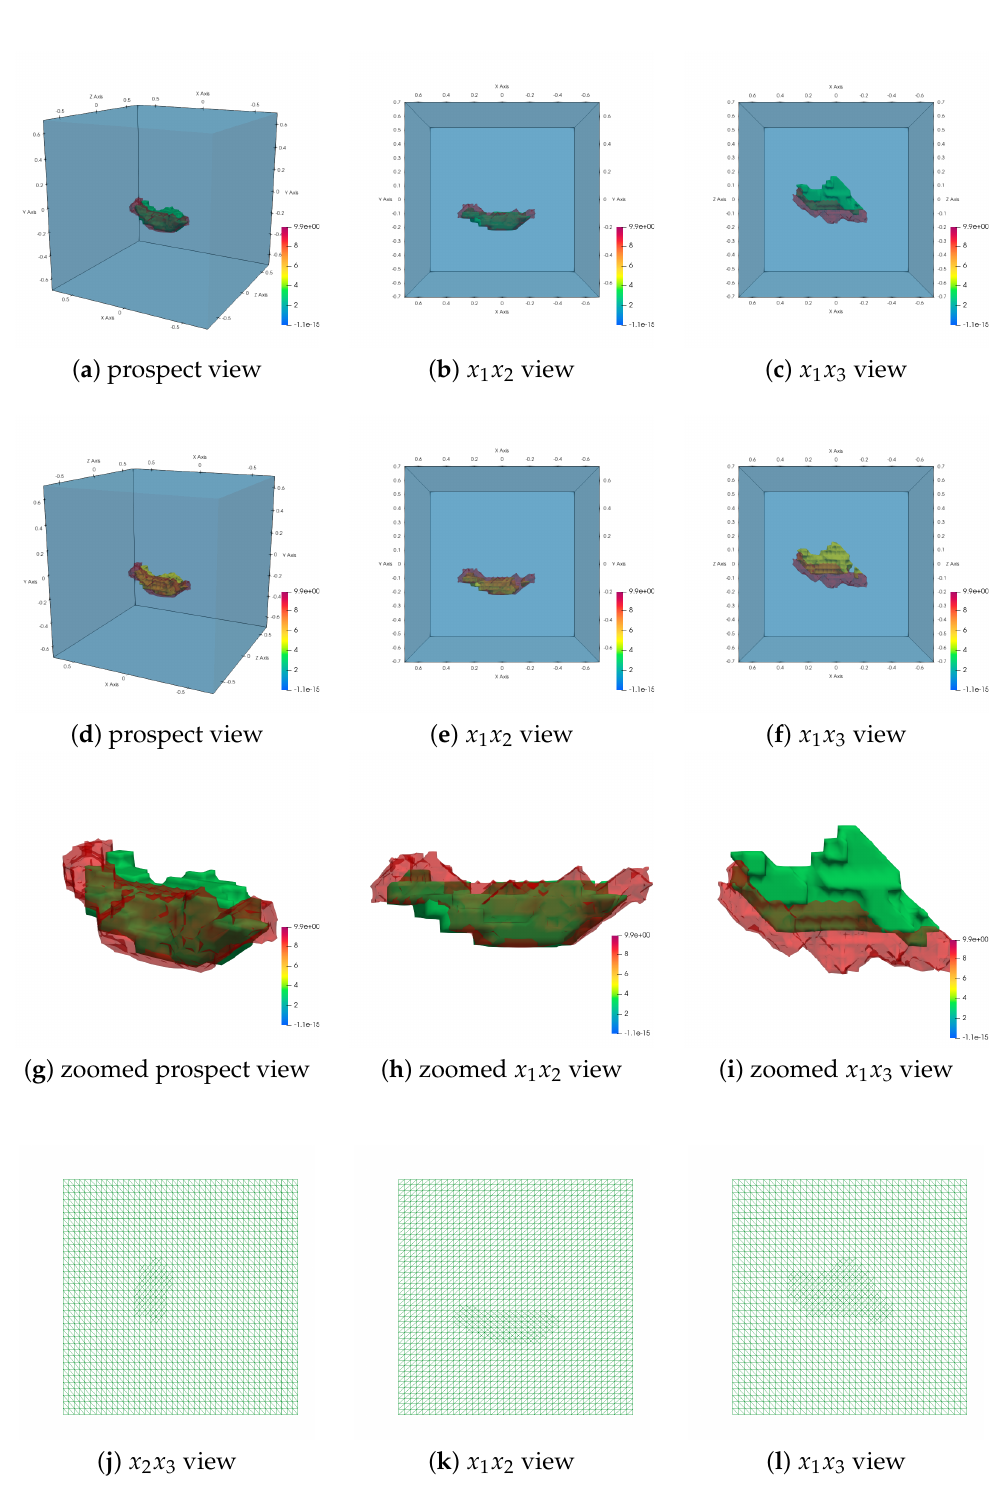
5.0 (in green color) of ε r obtained on the 0 ≈ 5.0 obtained on refined mesh K h 1 (in ≈ ε hk , k = 0,1. For comparison, we also present the FEM